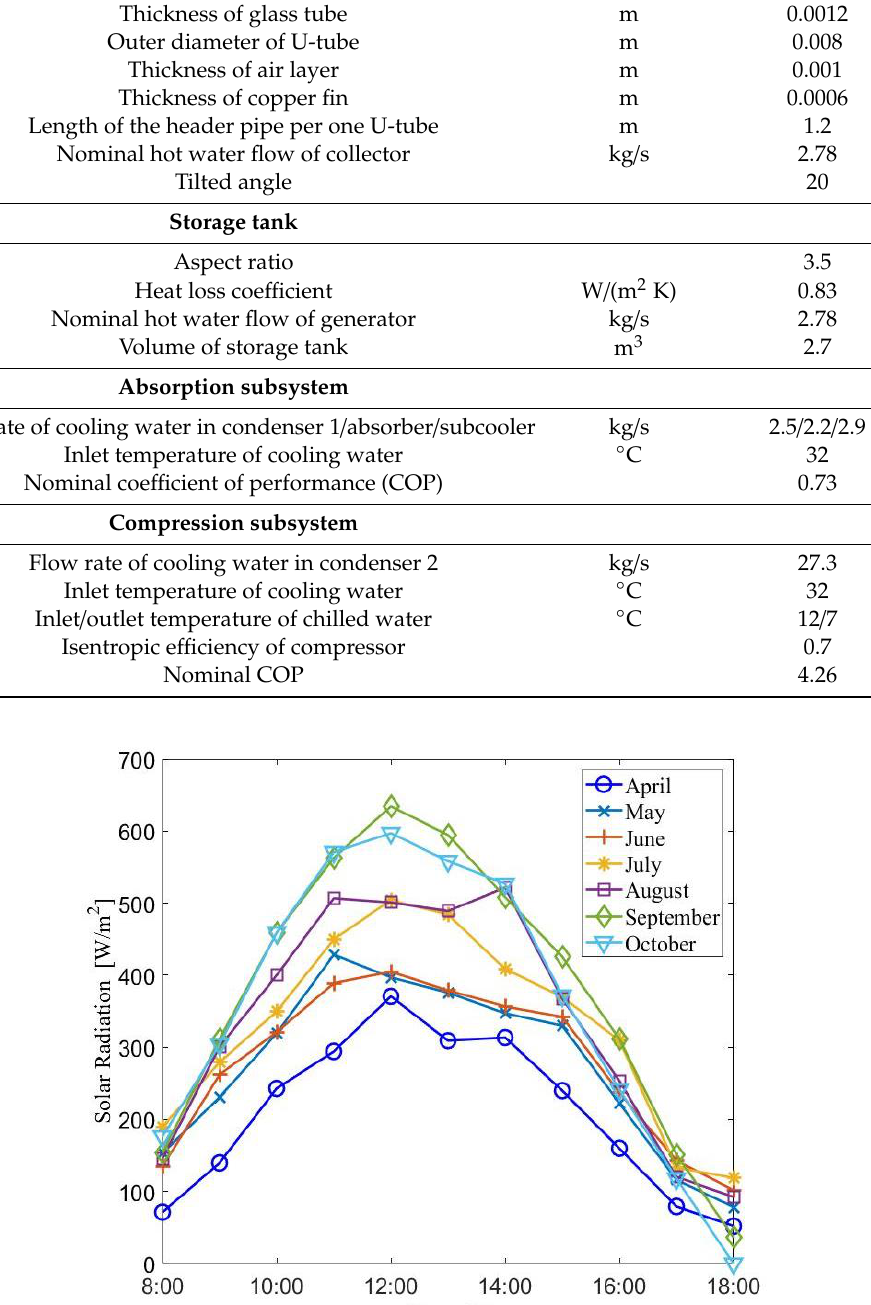
Figure 7. Ambient temperature.